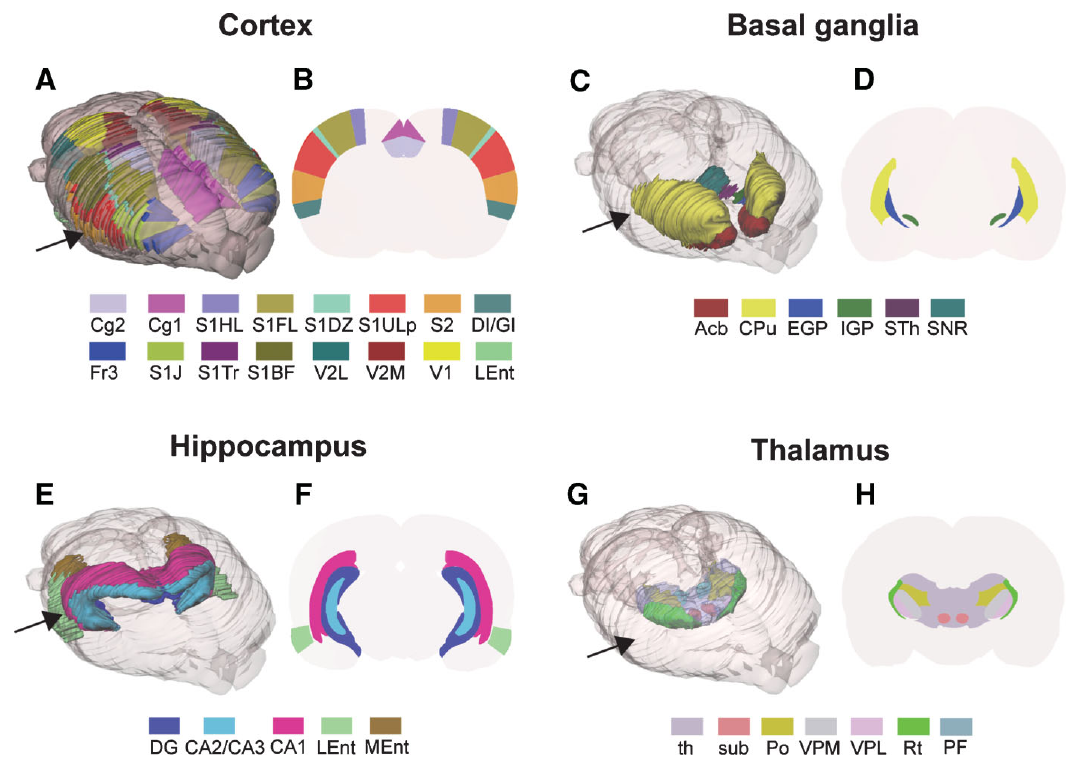
Figure 2. Examples of rat brain regions included in the 3-D rat brain atlas . ( A–H ) Atlas representations of four major brain regions visualized as solid, color coded 3-D surfaces within the transparent outer surface of the brain, and as corresponding 2-D coronal slices, obtained from anteroposterior levels indicated by arrows. ( A, B ) 16 selected cerebrocortical brain regions. ( C, D ) Major regions of the basal ganglia. ( E, F ) Hippocampus and entorhinal cortex. ( G, H ) Selected sub-regions of the thalamus. In ( G ) thalamus (th) is made transparent in order to visualize the underlying sub-regions. Cg2, cingulate cortex area 2;